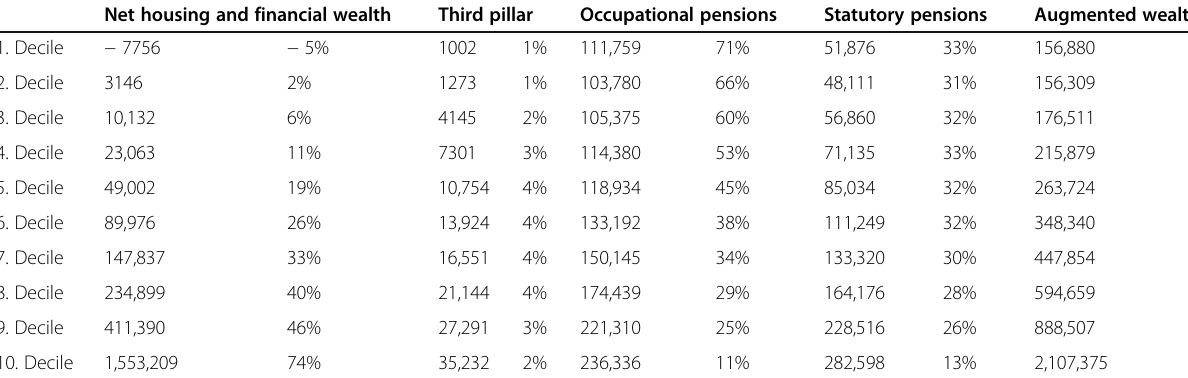
Table 3 Distribution of per capita household wealth in 2015 by net worth decile Net housing and financial wealth Third